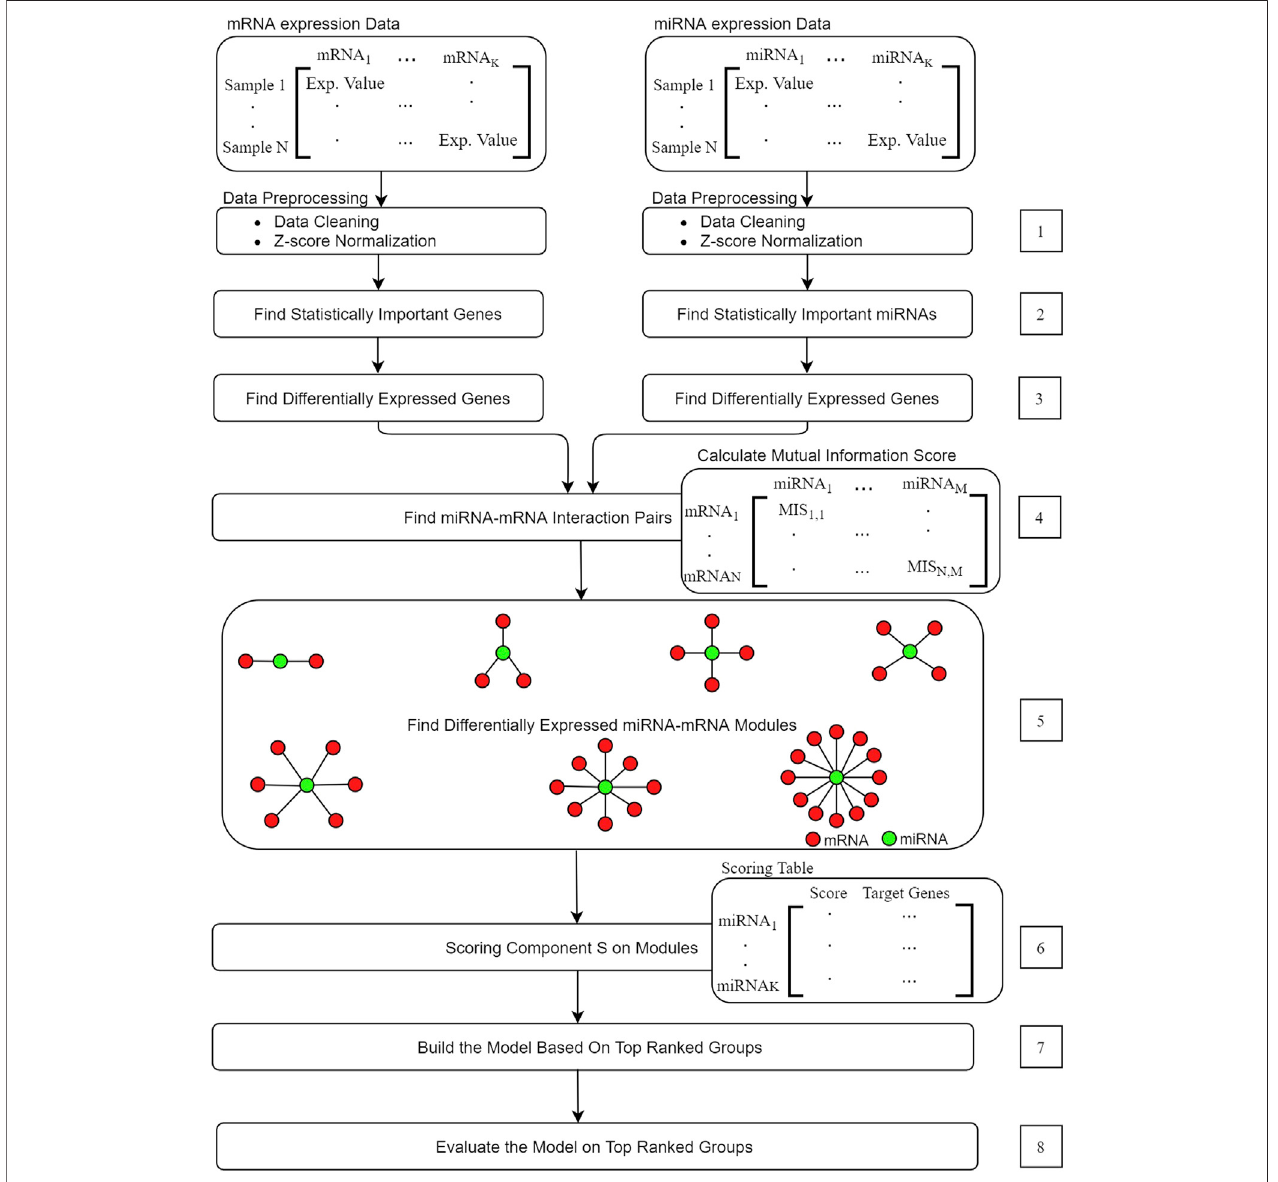
FIGURE 4 | miRModuleNet fl